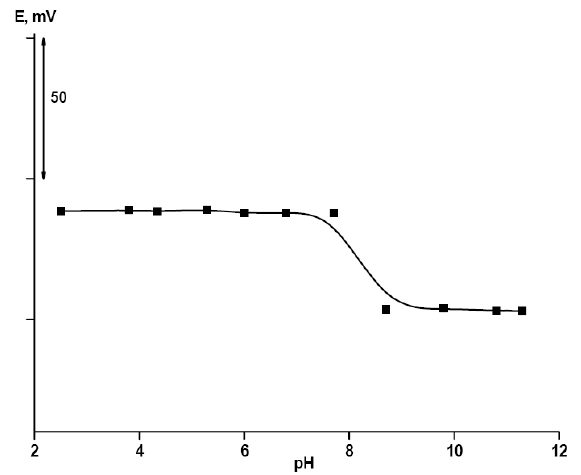
Fig. 3 Effect of the pH of test solution on the potential response of the DCF ion selective electrode (membrane 1), [DCF − ] = 1 × 10 − 2 mol L − 1